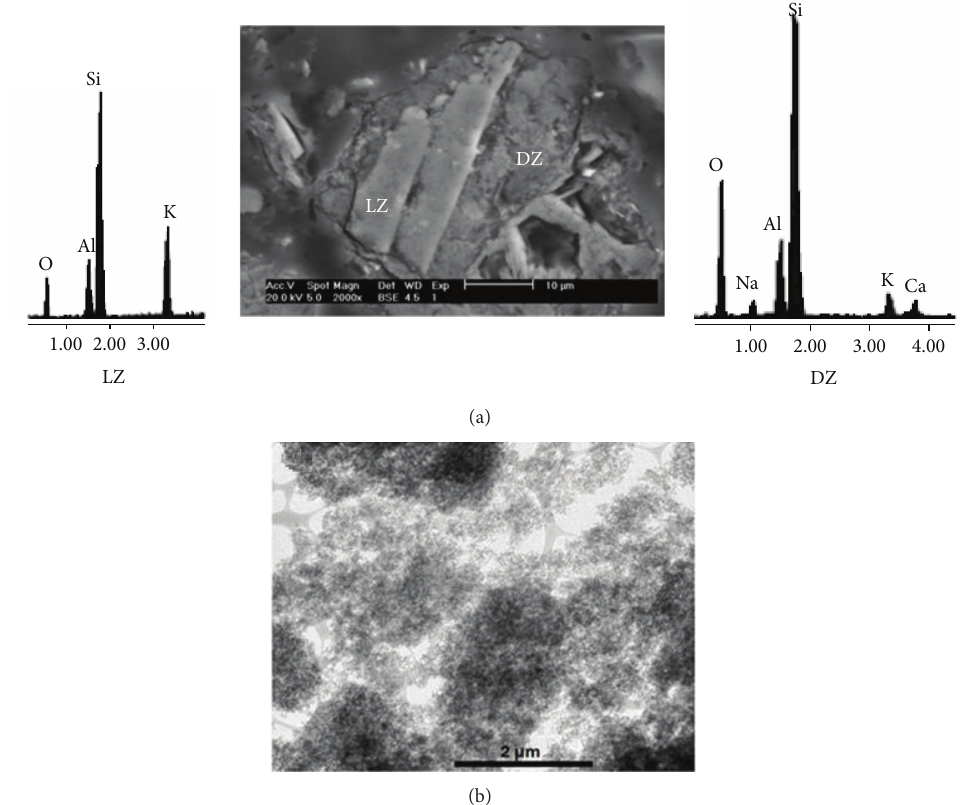
Figure 1: (a) SEM image of pure zeolite with Carlsbad twins and (b) TEM image of amorphous SiO 2(